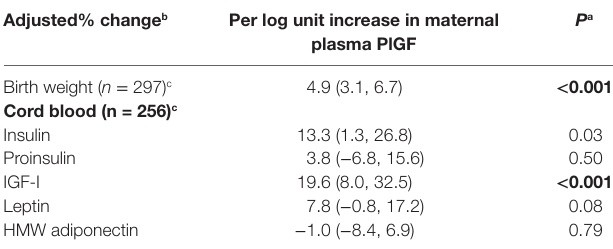
TaBle 3 | Adjusted percentage change (95% CI) in birth weight and cord blood biomarkers in relation to per log unit increase in maternal plasma PlGF concentration at 32–35 weeks of gestation.